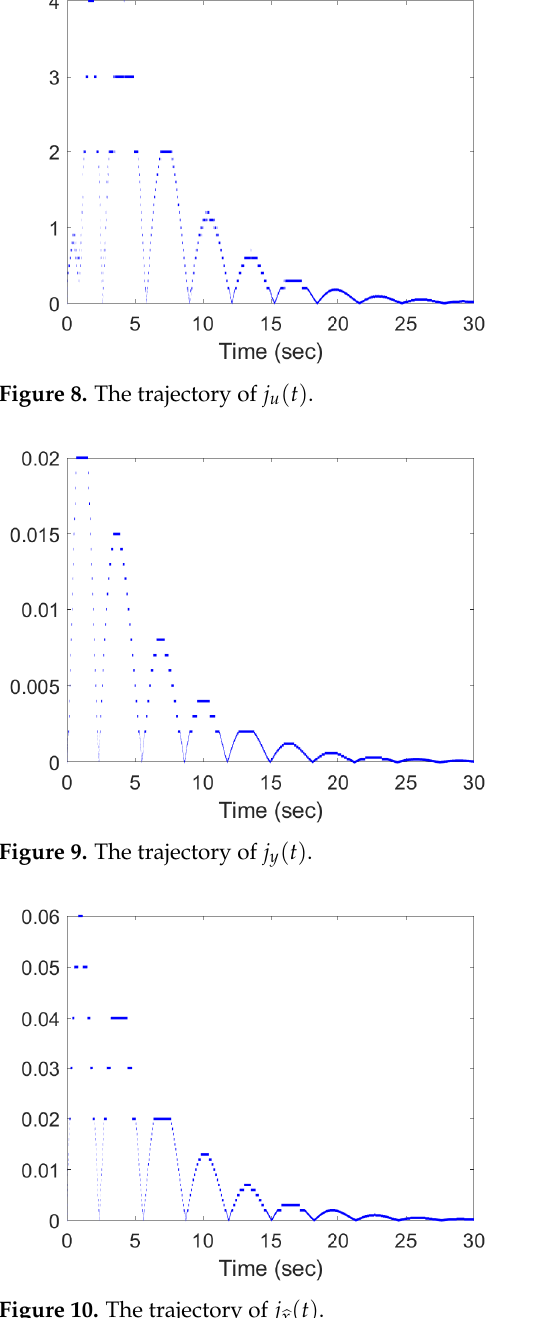
Figure 10. The trajectory of j